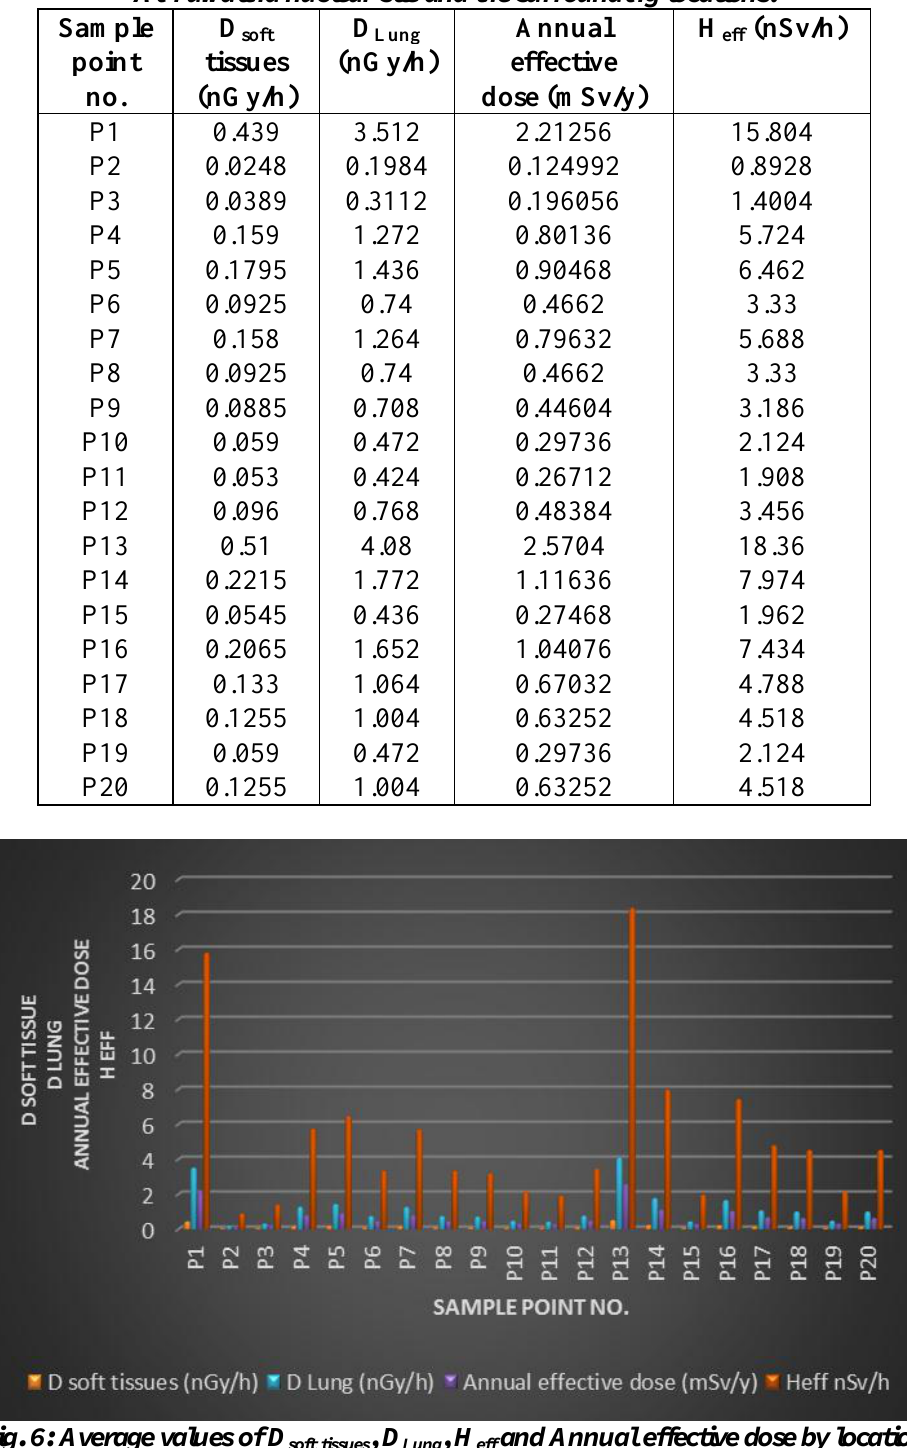
Table 2: Variation of dose relationship from indoor radon measurements from air in the Al-Tuwaitha nuclear site and the surrounding locations.